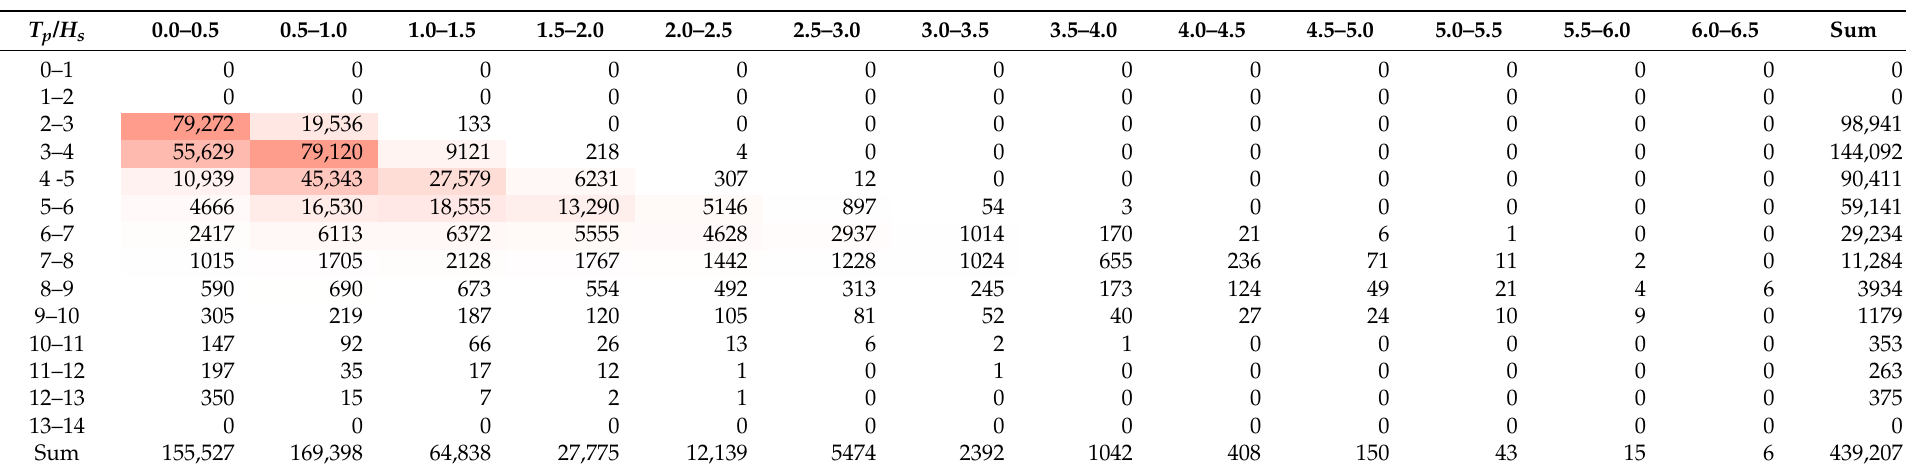
Table A5. Sea table for Central Adriatic region (locations